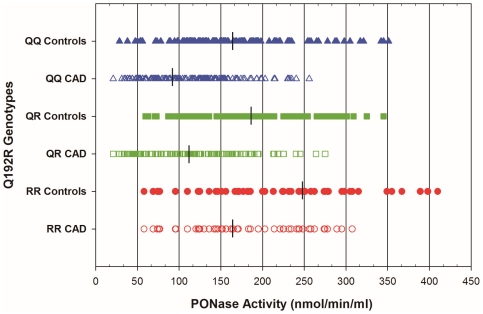
Individual data point for PONase activity in Controls and CAD patients for each PON1 Q192R genotype.Medians are indicated by crossbars.